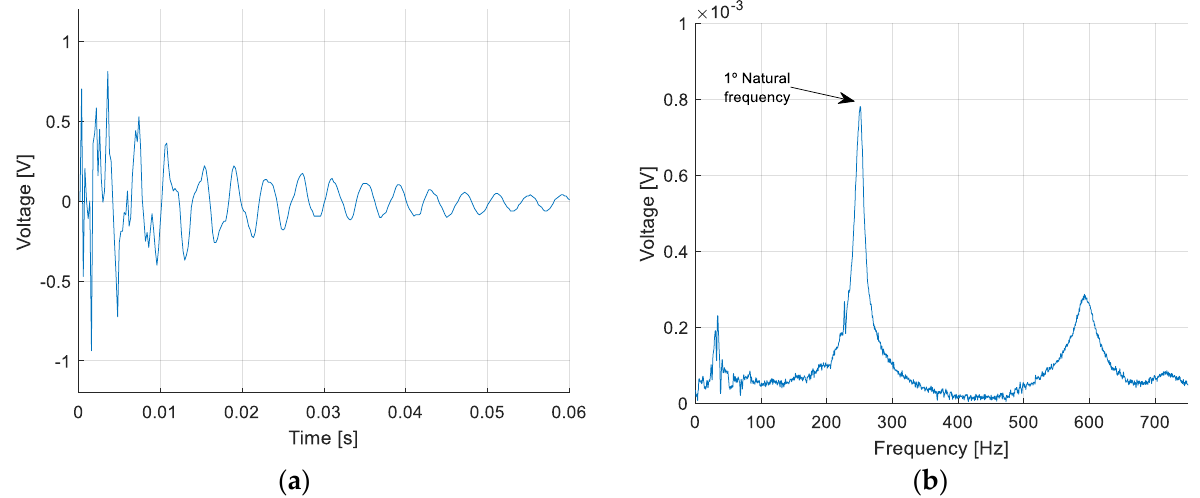
Figure 12. Example of a recorded signal obtained with the specimen PET-T at 70 °C: ( a ) in time domain; ( b ) in frequency domain.